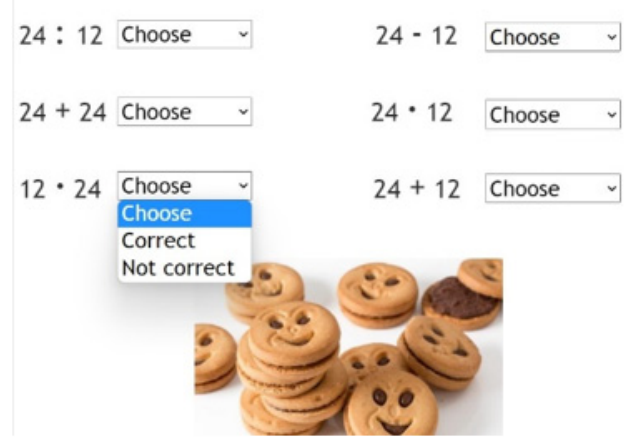
Figure 1. Example task from the word problem sub-test.